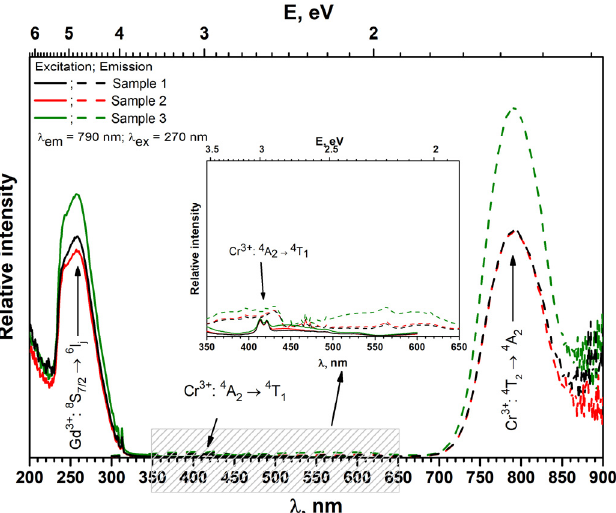
Figure 2. Excitation and emission spectra of GAGG:Ce,Cr,Mg,Ca powder samples ( λ ex = 270 nm). Inset represents zoomed in spectral region from 350 to 650 nm.